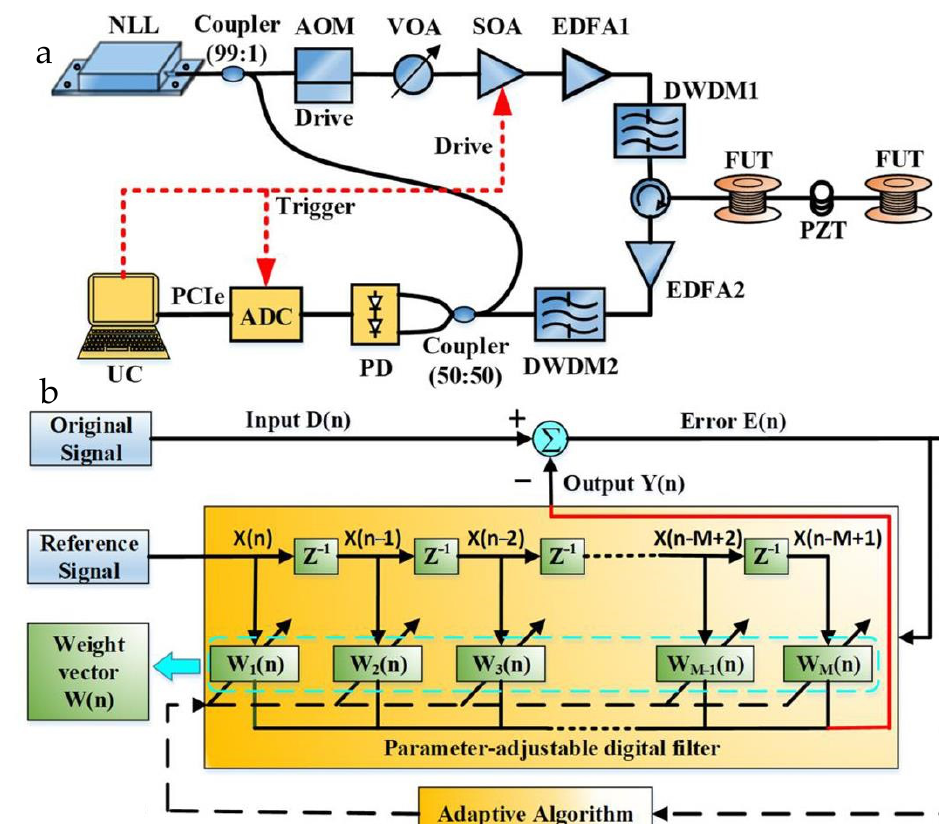
Figure 16. ( a ) Experimental setup. ( b ) Schematic diagram of adaptive filtering based on least mean square error (LMS) algorithm [66]. Table 5. Research progress on SNR enhancement.